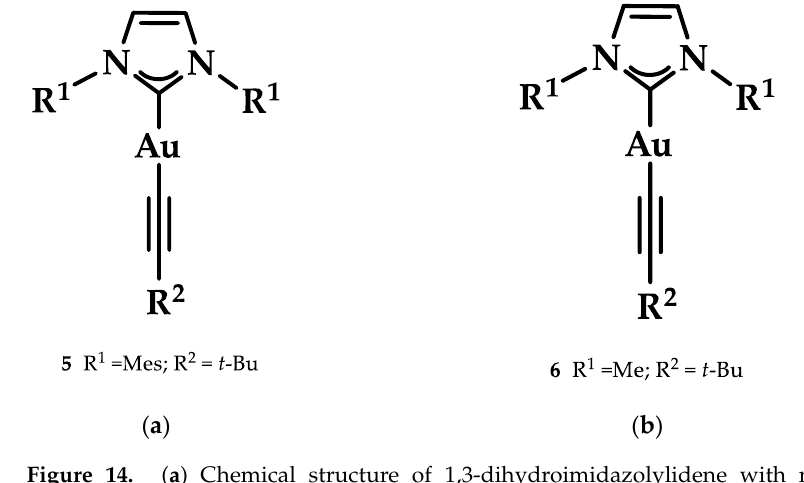
Figure 14. ( a ) Chemical structure of 1,3-dihydroimidazolylidene with mesitylene and tert -butyl- ethynyl ligands; ( b ) chemical structure of benzimidazolylidene with methyl and tert -butylethynyl